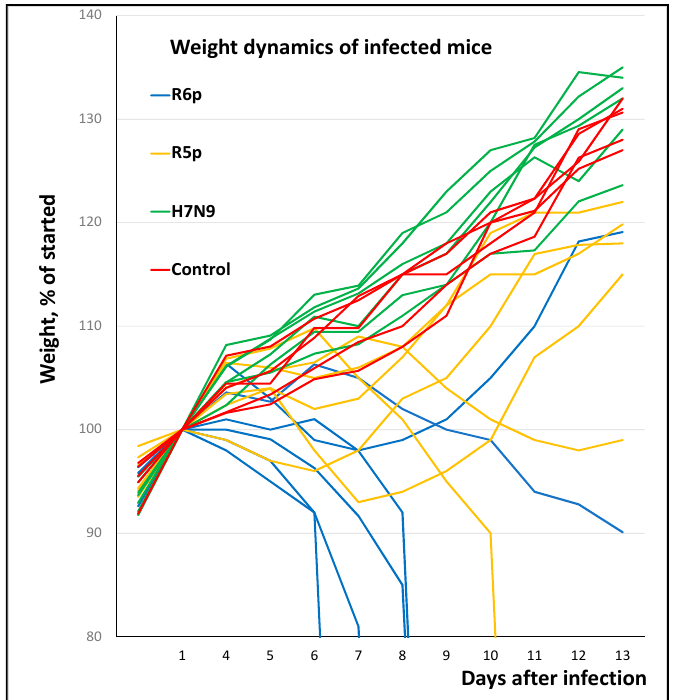
Figure 3. Weight dynamics and survival of mice infected with R5p, R6p and the A/mallard/Sweden/91/02 (H7N9) virus. Result of a typical experiment is presented.